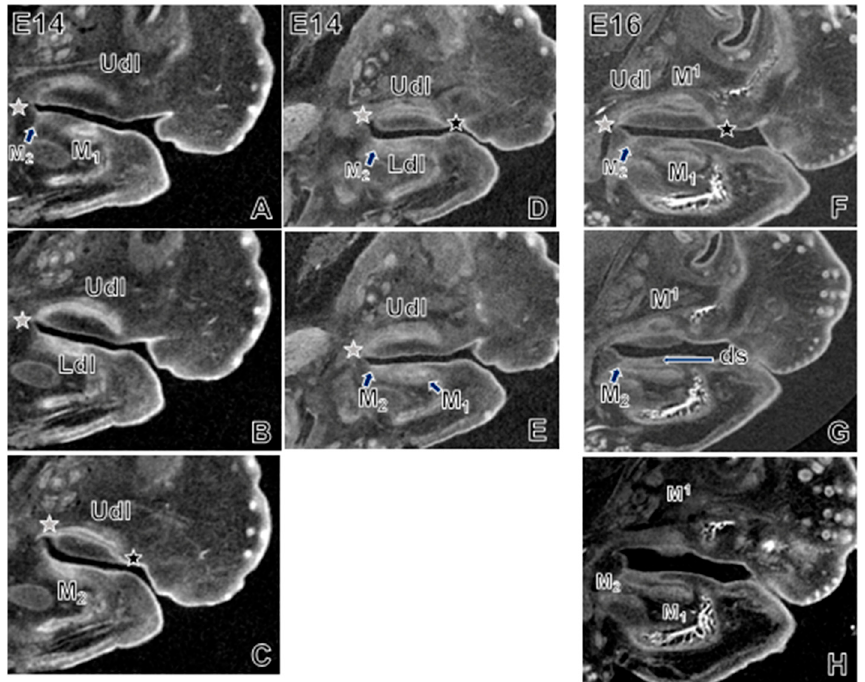
Figure 4. Molar morphogenesis in embryonic wild-type mouse. Coronal view of embryos aged ( A ) E14 and ( B ) E16 showing the lingual tilting (short yellow dotted line, right) of upper and lower M1 organs, and the buccal location of the upper M1 organs at E14. The M1 dental stalks (yellow dashed lines, left, and arrows, right) of the upper molar organs are laterally positioned relative to lower molar organs. By E16 the upper molar organs are wider than the lower organs (yellow dashed lines, left). Mineralizing dentary bone (bright white, arrowhead) is located buccal to the molar and the incisor (i). Long thin arrow ( B ) points to the wall of the dental follicle (crypt). Ab- breviations: e, eye; i, incisor; t, tongue.